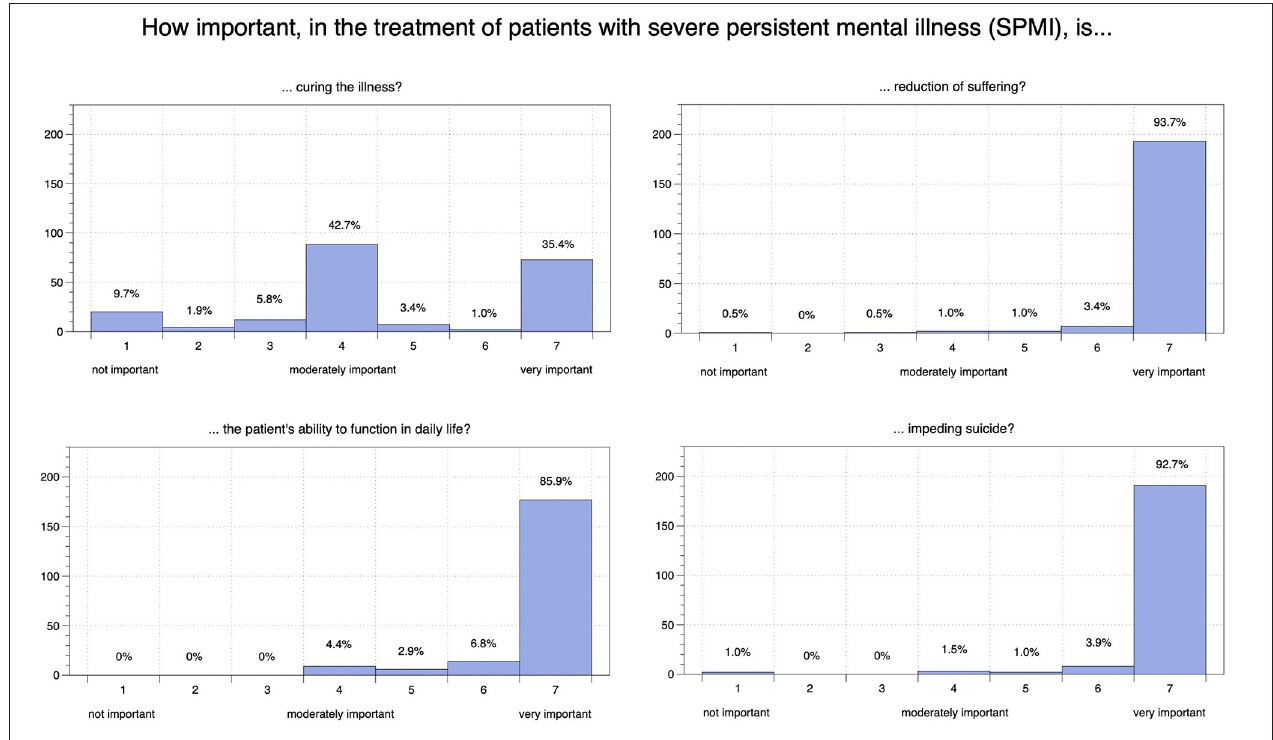
FIGURE 1 | Indian psychiatrists’ attitudes on general treatment of patients with